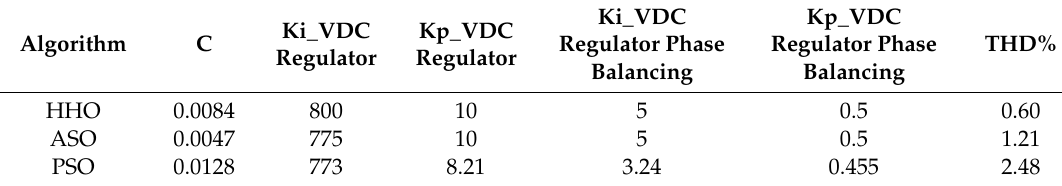
Figure 13. The curves of ASO, HHO, and particle swarm optimization (PSO).